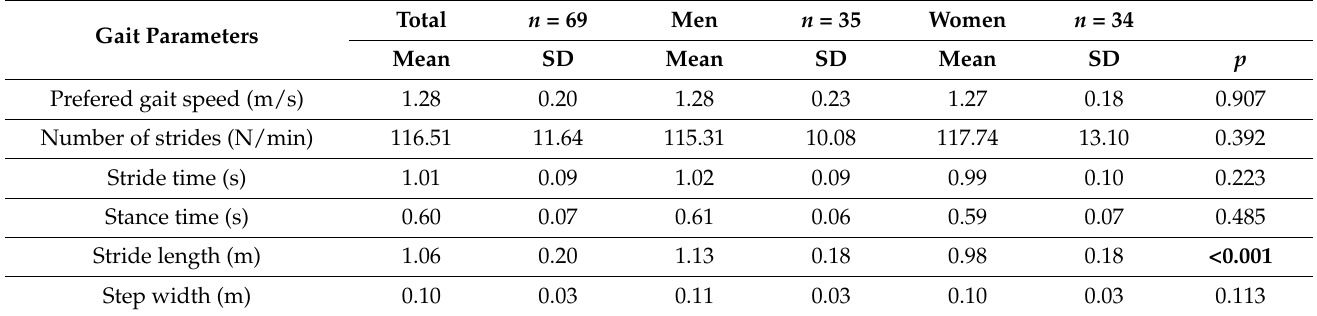
Table 2. Spatiotemporal gait parameters for men and women.